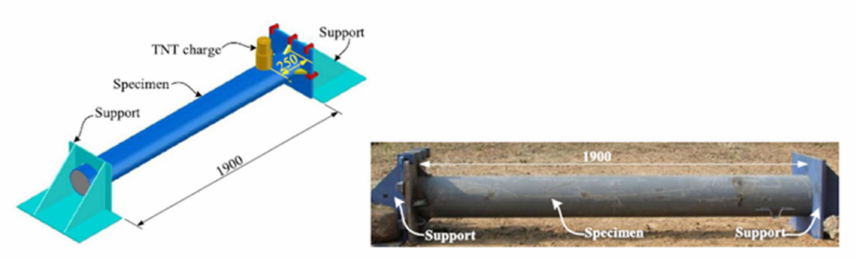
Figure 6. Schematic and field views of test setup [29]. Copyright permission obtained from